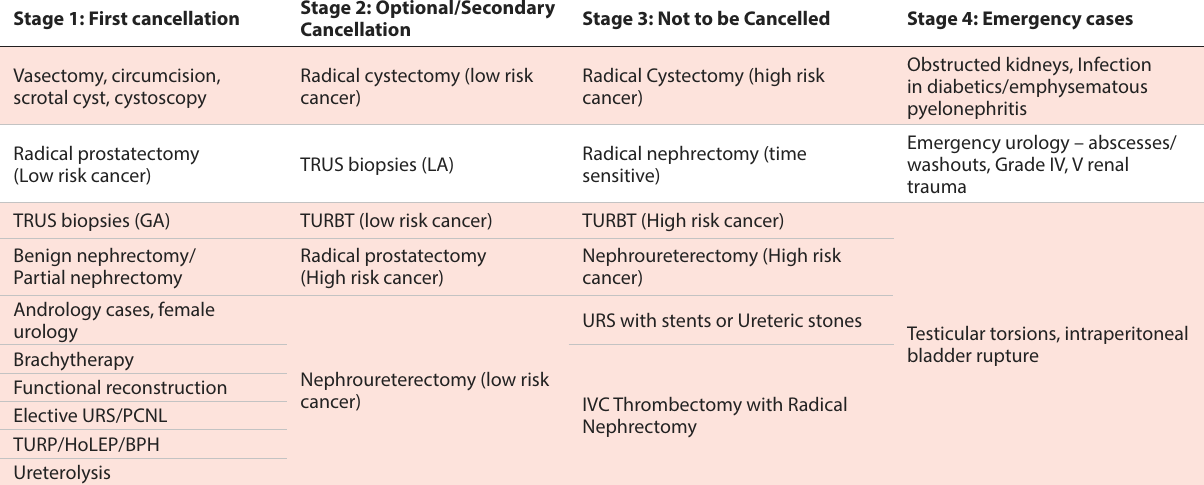
Table 1. Triage of urological operations for decision-making algorithm. Stage 1: First cancellation